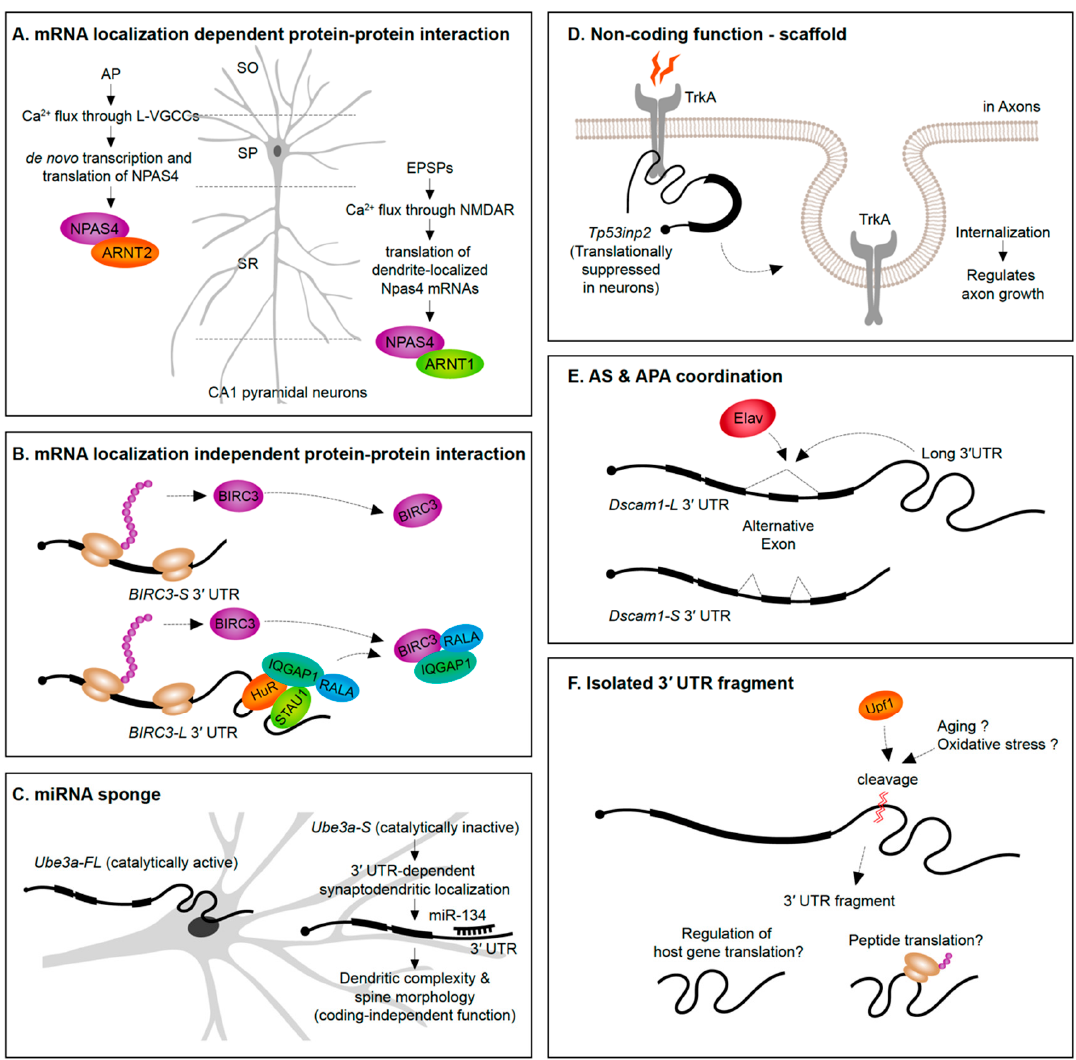
Figure 4. Newly emerging roles for 3 ′ UTRs. ( A , B ) mRNA 3 ′ UTRs can serve as scaffolds for the interactome of their host proteins. ( C ) 3 (cid:48) UTRs can serve a non-coding role as a sponge for miRNAs. interactome of their host proteins. ( C ) 3 ′ UTRs can serve a non-coding role as a sponge for miRNAs. ( D ) Translationally inactive 3 (cid:48) UTRs mRNA isoforms can impact internalization of receptor proteins ( D ) Translationally inactive 3 ′ UTRs mRNA isoforms can impact internalization of receptor proteins and influence axon growth. ( E ) 3 (cid:48) UTR sequences can act as mediators of alternative splicing on and influence axon growth. ( E ) 3 ′ UTR sequences can act as mediators of alternative splicing on the the same pre-mRNA. ( F ) Isolated 3 (cid:48) UTR fragments cleaved from mRNAs might regulate host gene same pre-mRNA. ( F ) Isolated 3 ′ UTR fragments cleaved from mRNAs might regulate host gene translation and / or encode peptides. AP, action potential; L-VGCC, L-type voltage-gated translation and/or encode peptides. AP, action potential; L-VGCC, L-type voltage-gated calcium channel; EPSP, excitatory postsynaptic potential; NMDAR, NMDA receptor; SO, stratum oriens; SP, stratum pyramidale; SR, stratum radiatum; CA1, cornus ammonis 1.